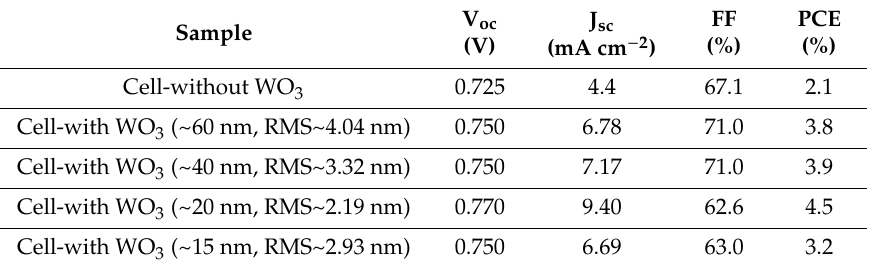
Figure 6. J–V curve characteristics of the device with structure of glass / ITO / WA-ZnONrod (250 nm) / (P3HT:PCBM) / WO 3 / EGaIn dependent on the thickness and morphology of WO 3 bu ff er layer. Table 2. Device parameters such as short-circuit current density (J SC ), open-circuit voltage (V OC ), fill factor (FF), and power conversion e ffi ciency (PCE) of device dependent on the thickness and morphology of WO 3 bu ff er layer.